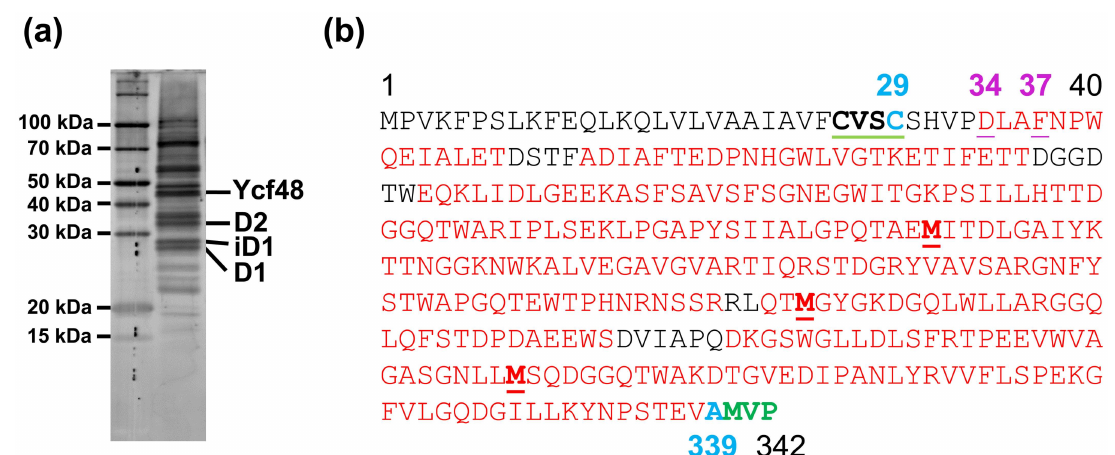
Figure 5. Electrophoretic analysis of the preparation isolated from the strain expressing His-D2 and lacking CP47 ( a ) and sequence of the Ycf48 with designated crucial residues and coverage obtained by its MS bottom–up analysis ( b ). ( a ): The preparation was analyzed by SDS-PAGE, and after staining with Coomassie, the bands of Ycf48, D2, and both forms of the D1 protein were identified using MS. ( b ): The part of Ycf48 sequence identified after in-gel digestion using chymotrypsin and/or Asp-N protease is depicted in red letters. The designated amino acid residues are: (i) C29 residue (in blue) assumed to be the initial C residue of the putative lipoprotein; (ii) D34 residue (numbered and underlined in violet) identified as the most N -terminal residue in the Asp-N fragments; (iii) F37 residue (numbered and underlined in violet) annotated as the initial protein residue in SwissProt (P73069); M151, M288, and M224, cleavage sites by cyanogen bromide (in bold and underlined), and (iv) A339 residue (in blue) as the last residue found in the both chymotrypsin and Asp-N fragments. The non-canonical lipobox CVSC is designated with bold letter and green underline, putative cleaved MVP sequence is in